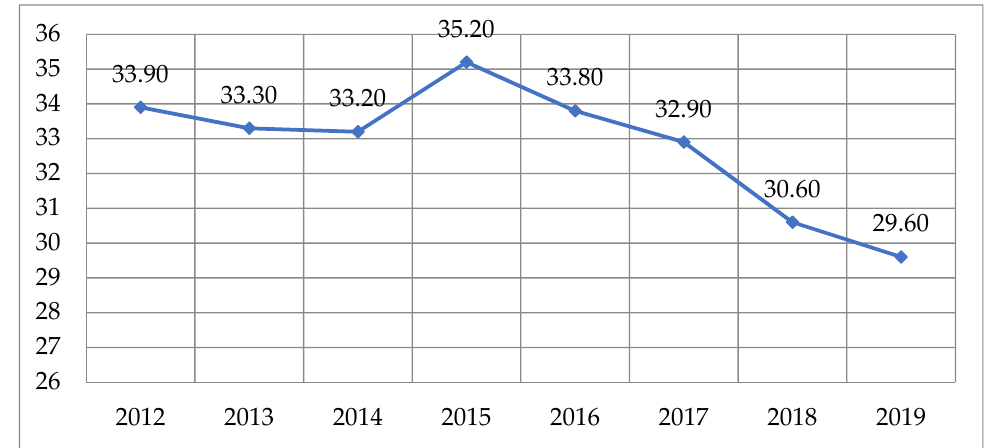
Figure 2. Dynamics of the coefficient of replacement of wages with a pension in Russia, %.